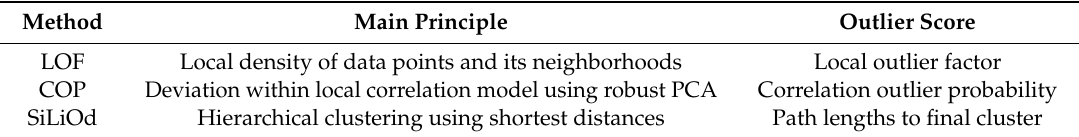
Table 2. Overview of the outlier detection techniques and outlier score